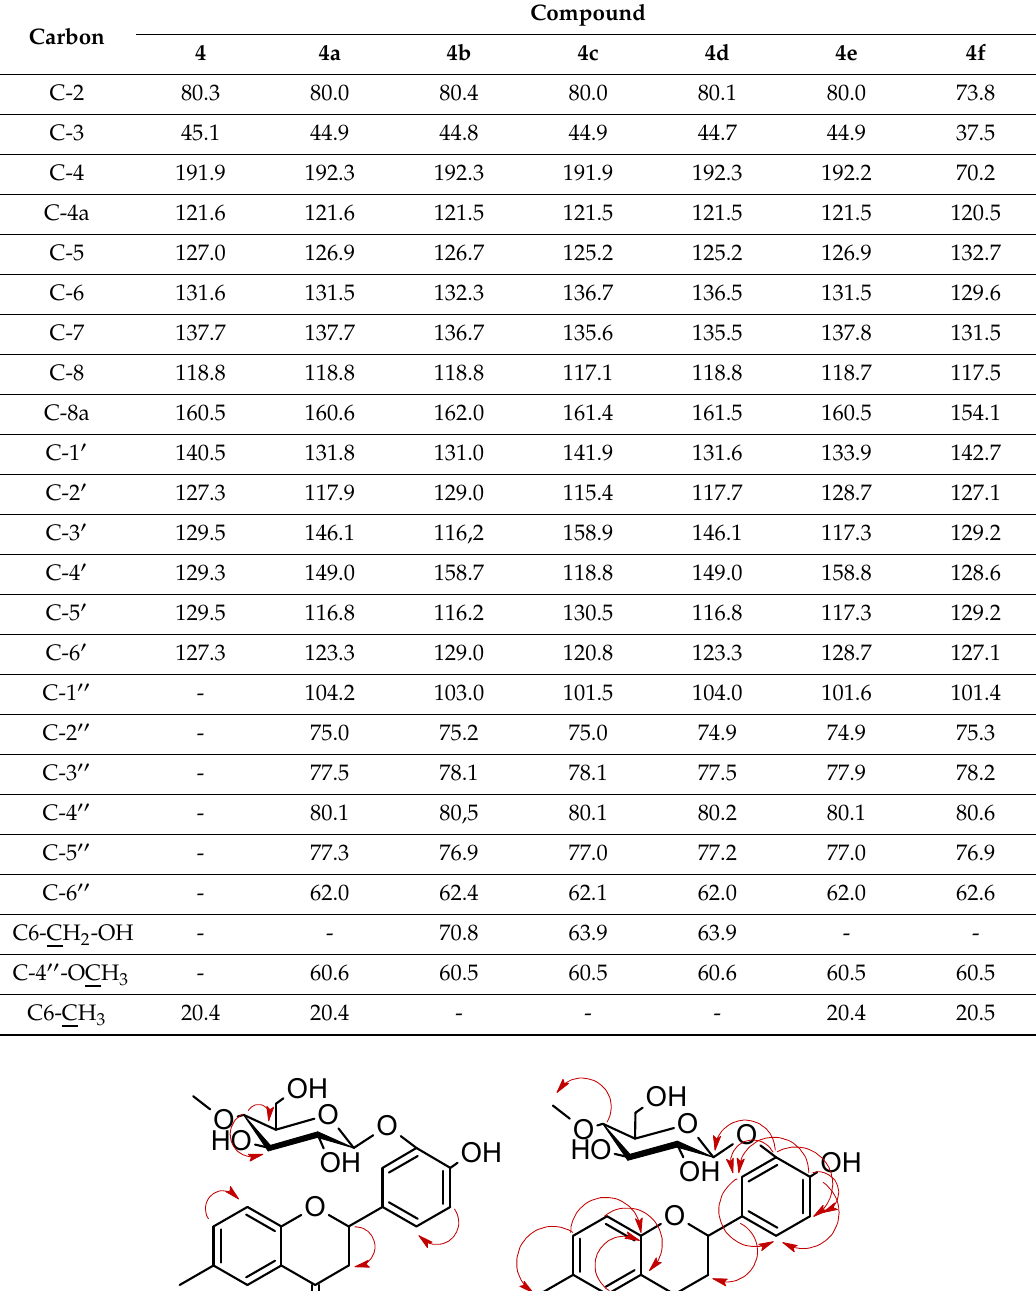
Table4. 13 C-NMRchemicalshifts δ (ppm)of6-methylflavanone( 4 )andproductsofitsbiotransformation 4a – 4f in Acetone-d6, 151 MHz (Supplementary